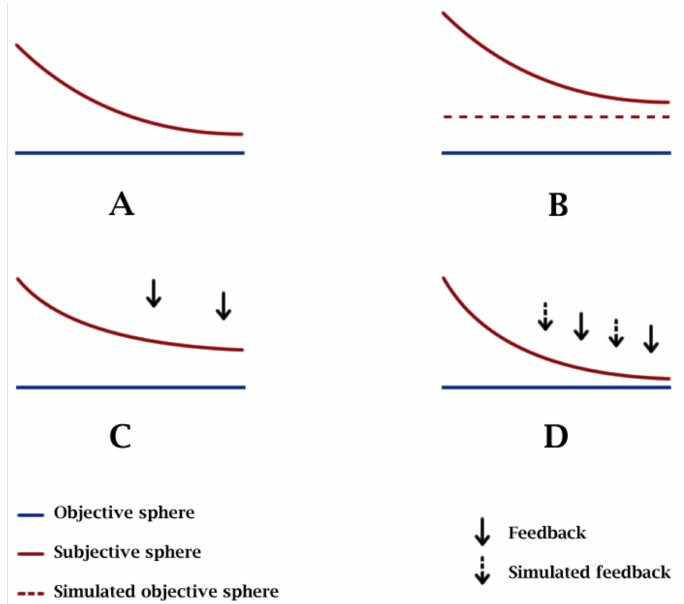
Figure 3. Simplified models of subjective sphere optimization processes. ( A ) general process; ( B ) deviated simulated reality; ( C ) reactive approach; ( D ) proactive